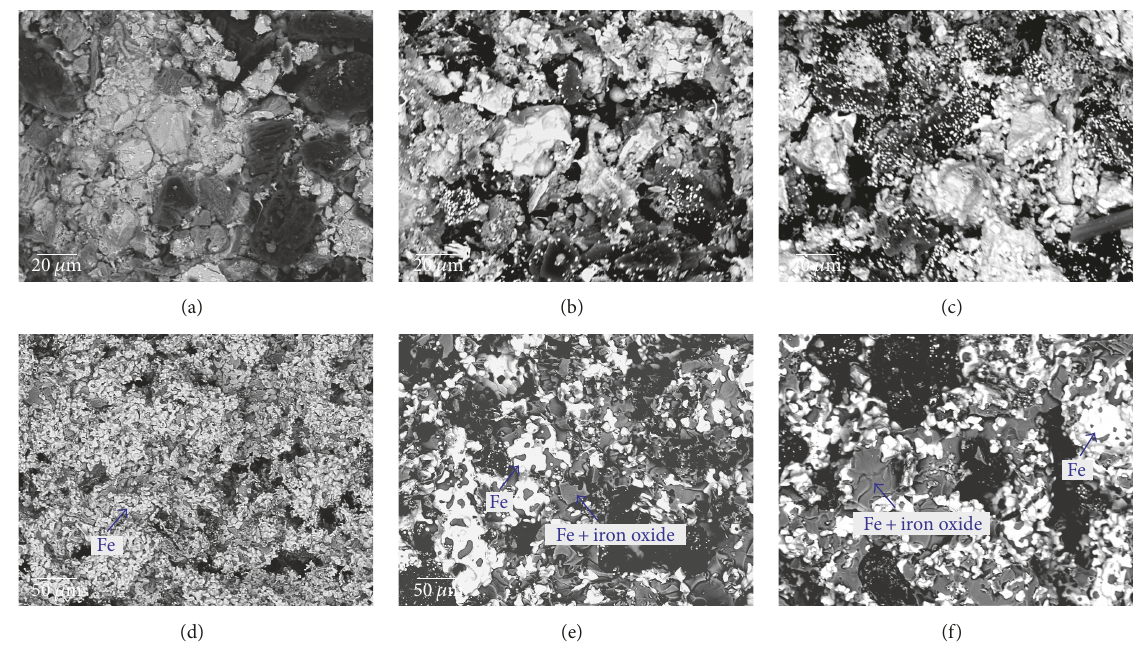
Figure 8: SEM backscattered images of different carbon-bearing pellets after reduction at 1273 and 1523 K. (a) 1273 k, cow dung 0%; (b) 1273 k, cow dung 7.8%; (c) 1273 k, cow dung 14.0%; (d) 1523 k, cow dung 0%; (e) 1523 k, cow dung 7.8%; (f) 1523 k, cow dung